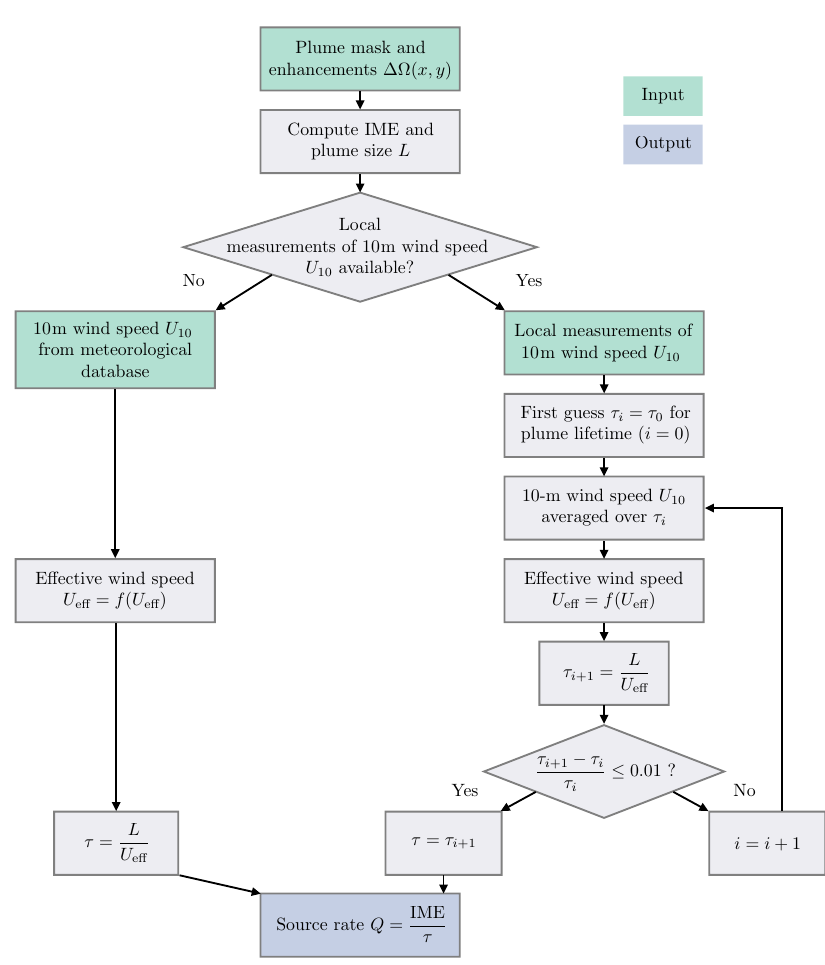
Figure 5. Flow chart describing the IME retrieval algorithm. Algorithm inputs are shown in green, operations in grey, and output in blue. There are two possible paths depending on the availability of 10m wind speed data: (a) local high-frequency wind speed measurements at the location of the source (right branch), and (b) a temporally averaged meteorological database (left branch).